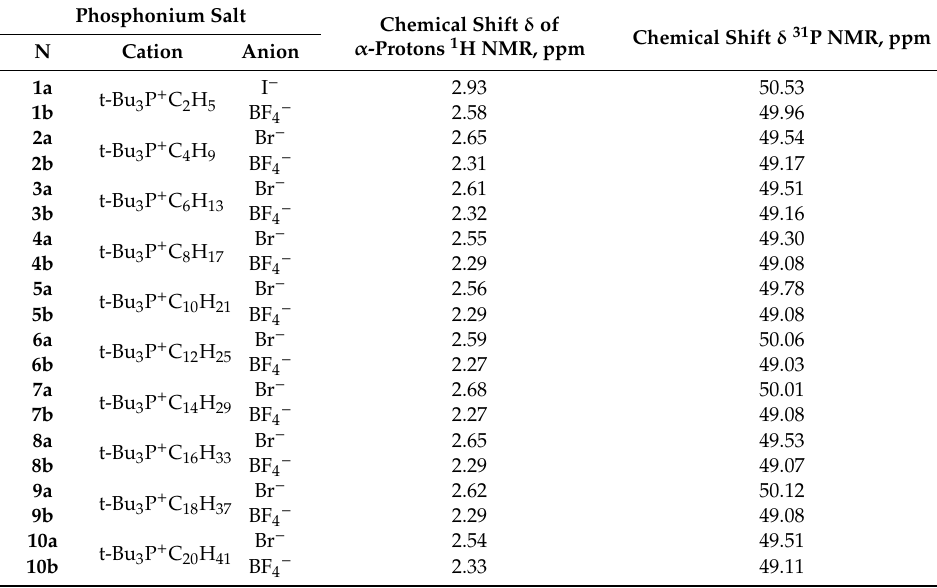
Table 1. 1 H NMR chemical shifts ( δ (ppm), CDCl 3 , 400 MHz, 20 °C) and 31 P{ 1 H} NMR shifts ( δ (ppm), CDCl 3 , 161.7 MHz, 20 °C.